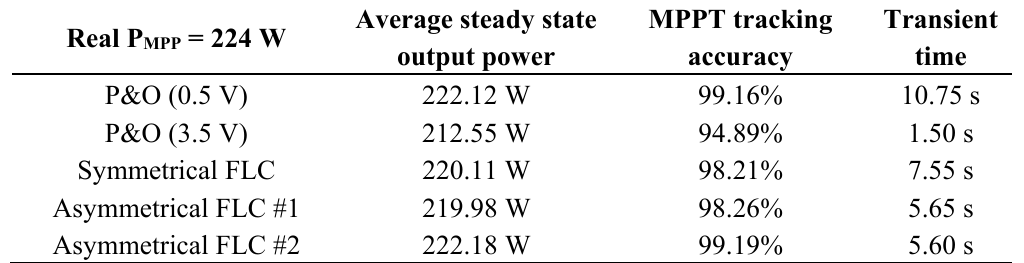
Table 6. Summarized experimental performance of different methods (1000 W/m 2 test